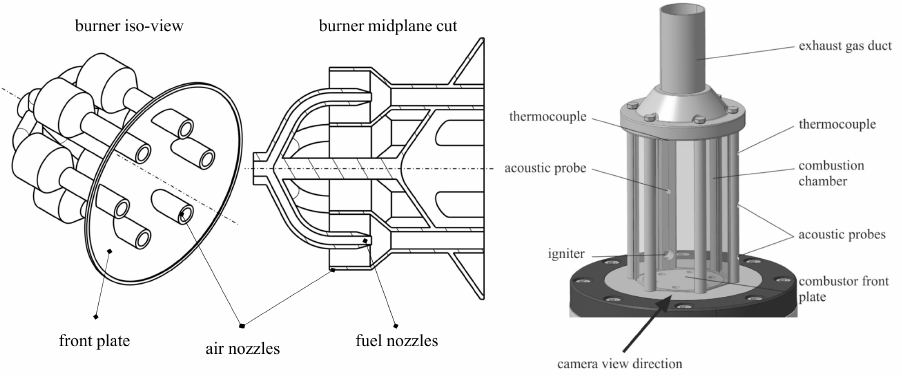
Figure 3. Setup of the laboratory scale burner system [42–44].